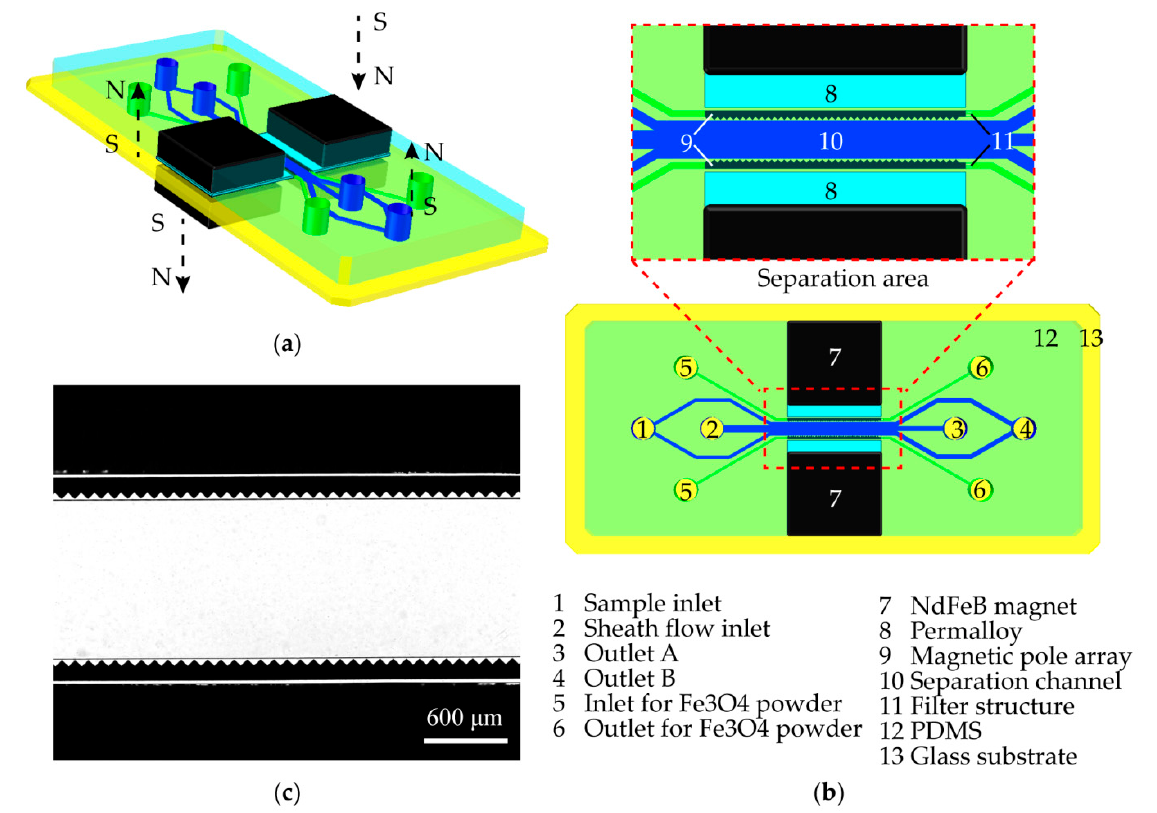
Figure 1. Design and image of the microfluidic system: ( a ) Overall structure of the system; ( b ) Schematic illustration on the system design; ( c ) Microscopic image on the separation area.